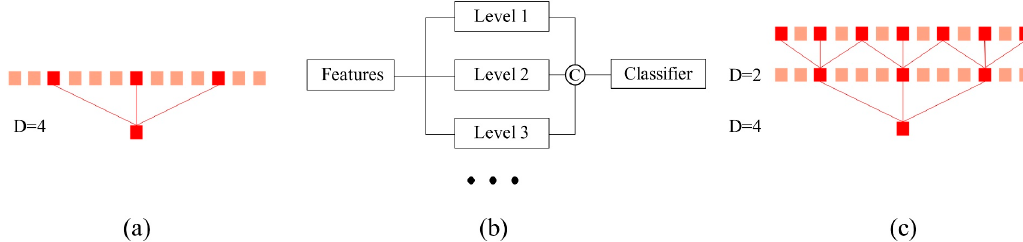
Figure 3. ( a ) One dimensional atrous convolution with an atrous rate of 4. ‘D’ represents the atrous rate. ( b ) An illustration of the commonly used direct concatenation strategy. ( c ) One dimensional atrous convolution with an atrous rate of 4 in the hierarchical cascade way.